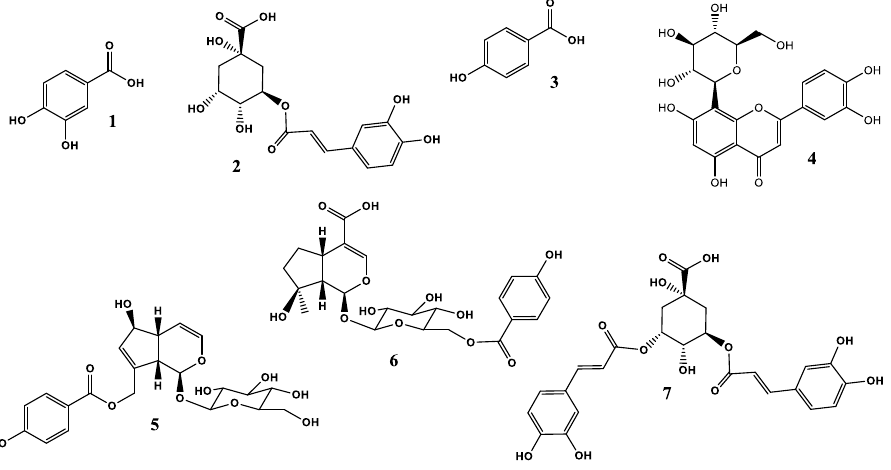
Figure 2. Chemical structures of marker compounds 1 – 7 isolated from the leaves of V. rotundifolia .